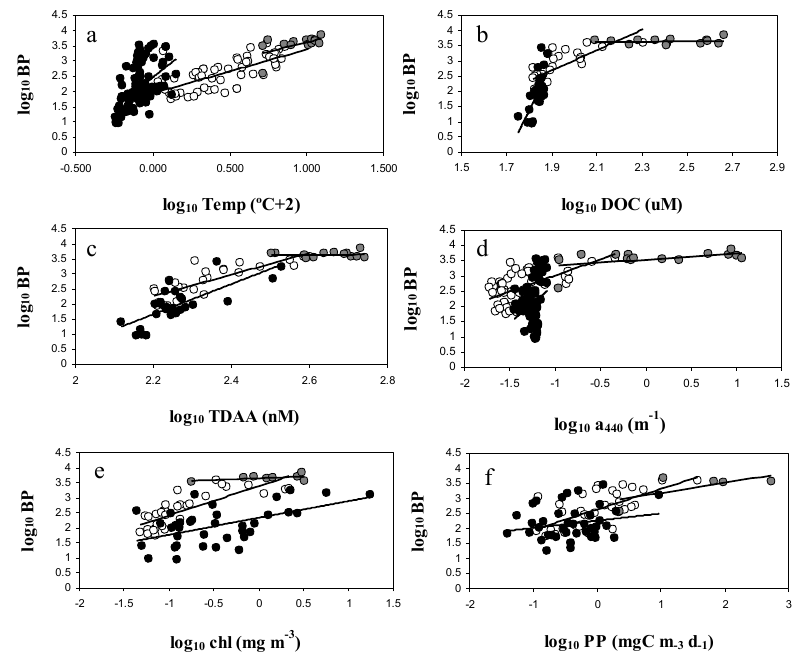
Fig. 5. Bivariate plots between different environmental variables and bacterial production (BP, µgCm − 3 d − 1 ), all log 10 transformed. Grey circles: River samples. White circles: Upper Mixed Layer samples. Black circles: Below mixed layer samples. Results of the regression analyses are detailed in Table 3.